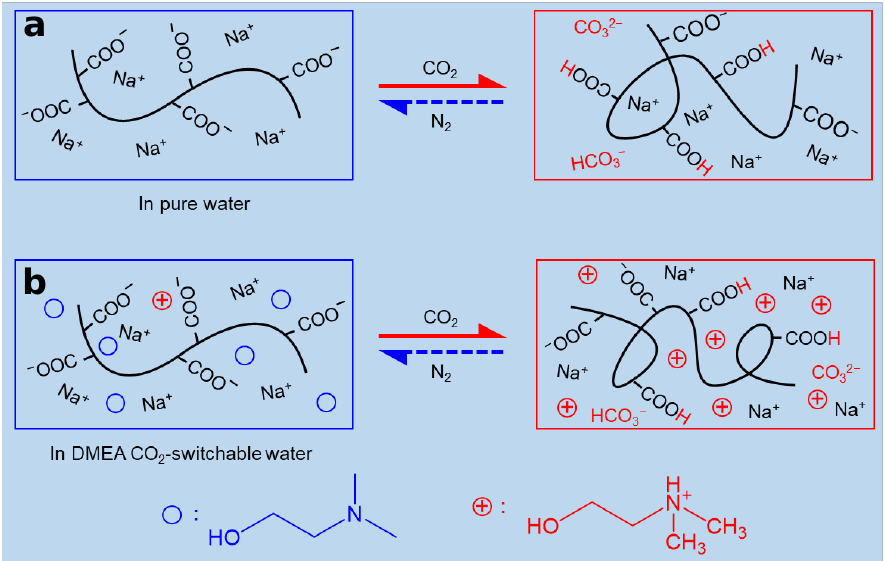
Scheme 2. Schematic illustration of the mechanism for CO 2 -switchable viscoelasticity of NaPAA in ( a ) pure water, and ( b ) DMEA solution.